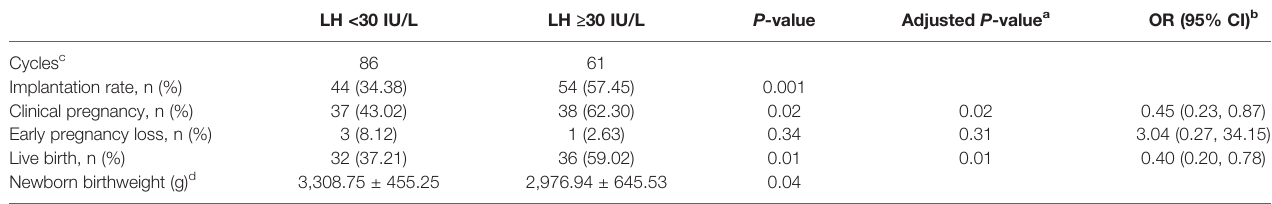
TABLE 5 | Pregnancy outcomes between the LH <30 and LH ≥ 30 groups in LUF